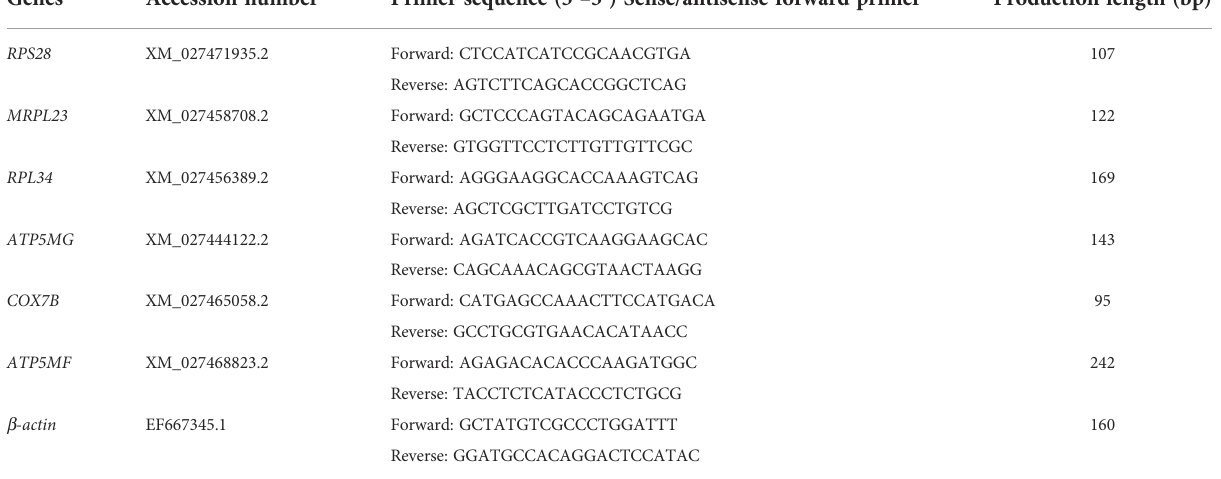
TABLE 1 Primers used for the RT-qPCR in this